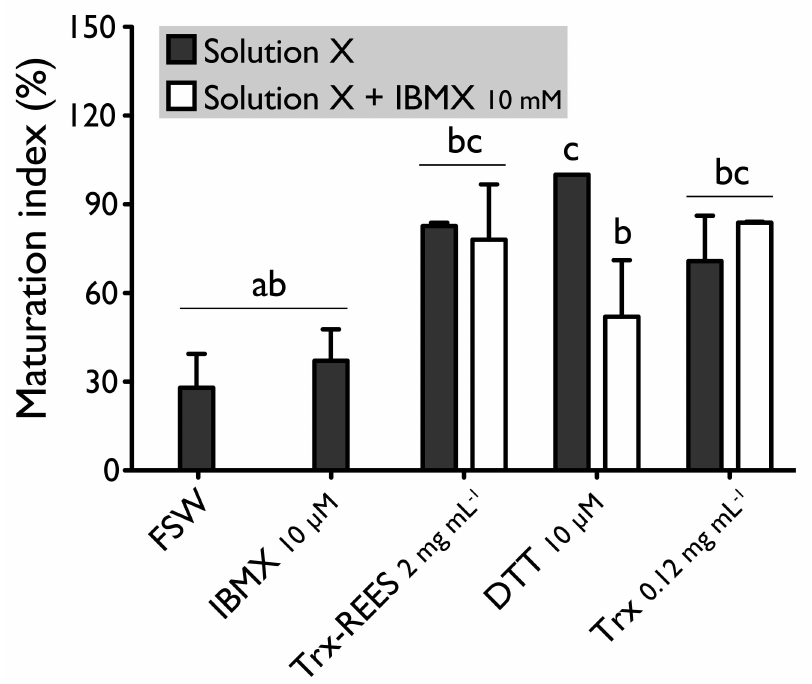
Figure 5. Effect of IBMX (10 µ M), on H. tubulosa oocyte maturation, induced by Trx-REES (2 mg mL − 1 ), DTT (10 mM) or thioredoxin from E. coli (Trx, 0.12 mg mL − 1 ). Values are means of maturation index ± SD ( n = 3 individuals). Means sharing at least one letter are not significantly different (T Tukey ≥